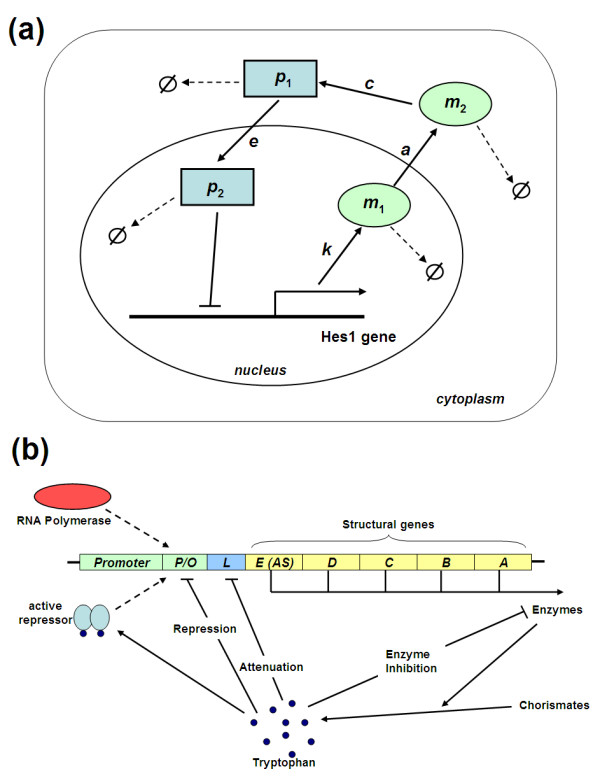
(a) Schematic representation of the Hes1 network. (b) Schematic diagram of the tryptophan operon system. 5 genes are denoted as E (AS), D, C, B and A. P, O, L denotes the promoter, operator and leader region, respectively. Blunt arrow represents inhibition while normal arrow represents activation.